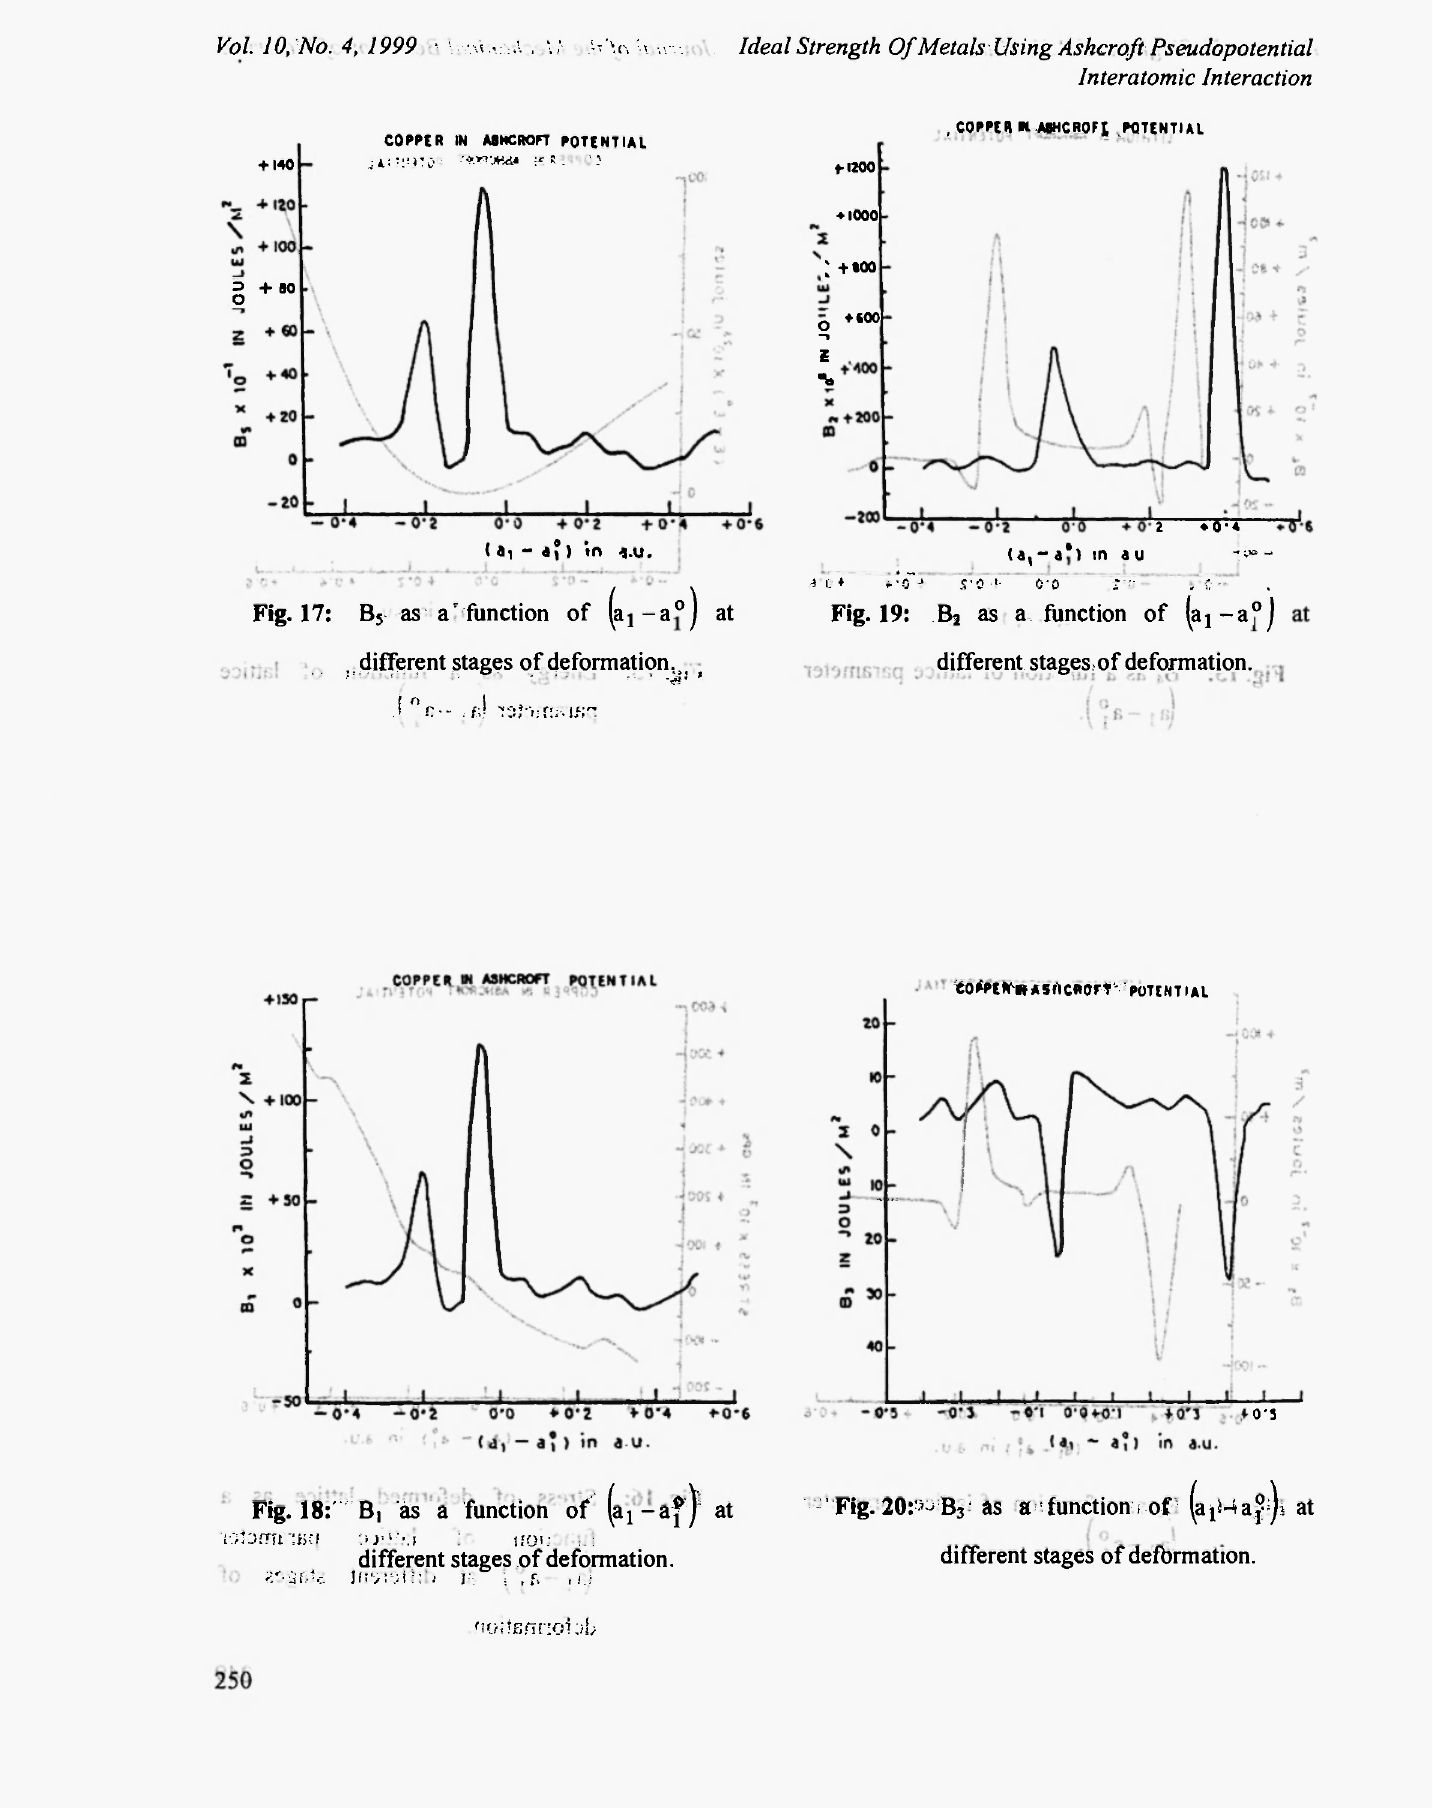
different stages of deformation.